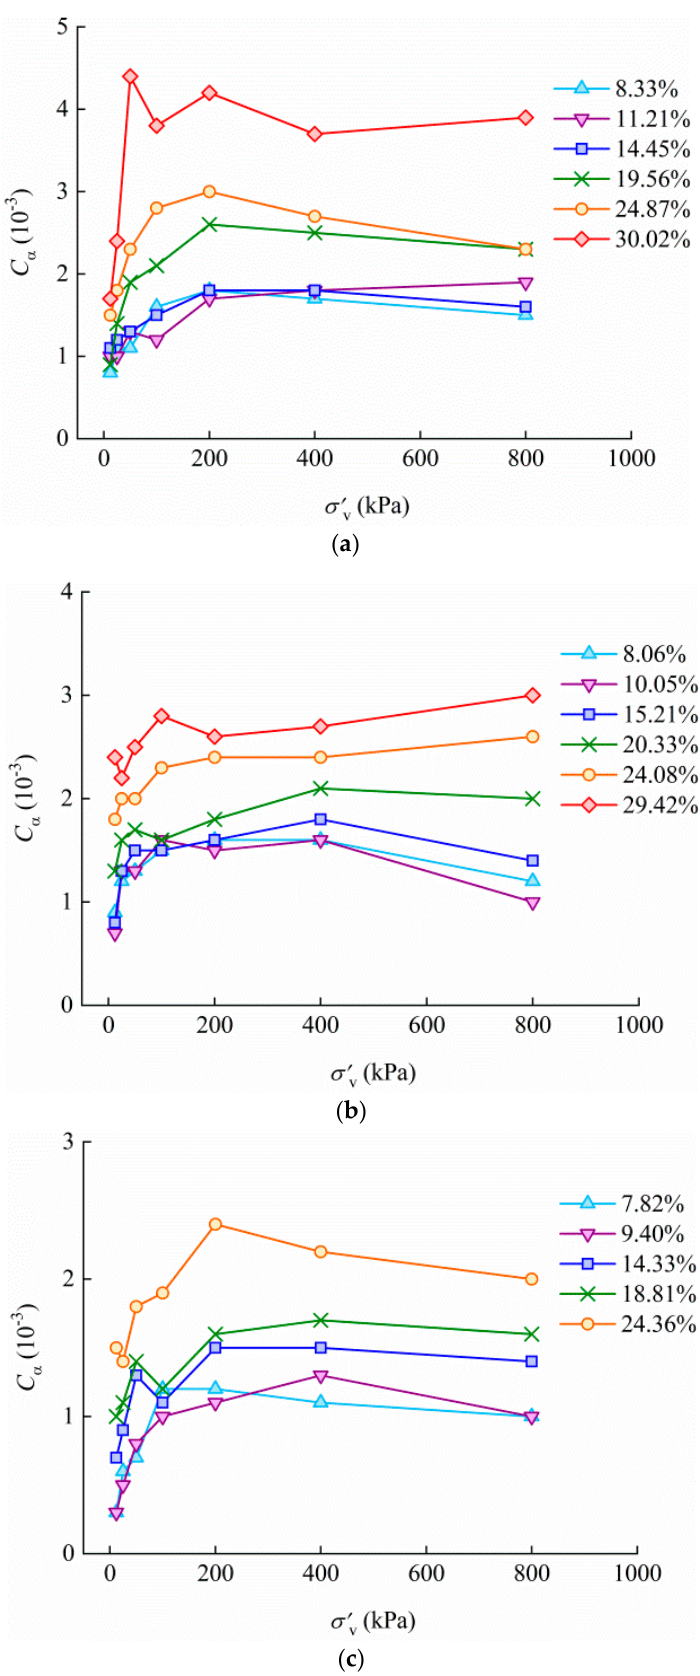
σ′ Figure 5. C α – curves at different absolute water contents for ( a ) TJ, ( b ) QD, and ( c ) WH. Figure 5. C α – σ (cid:48) v v curves at different absolute water contents for ( a ) TJ, ( b ) QD, and ( c )